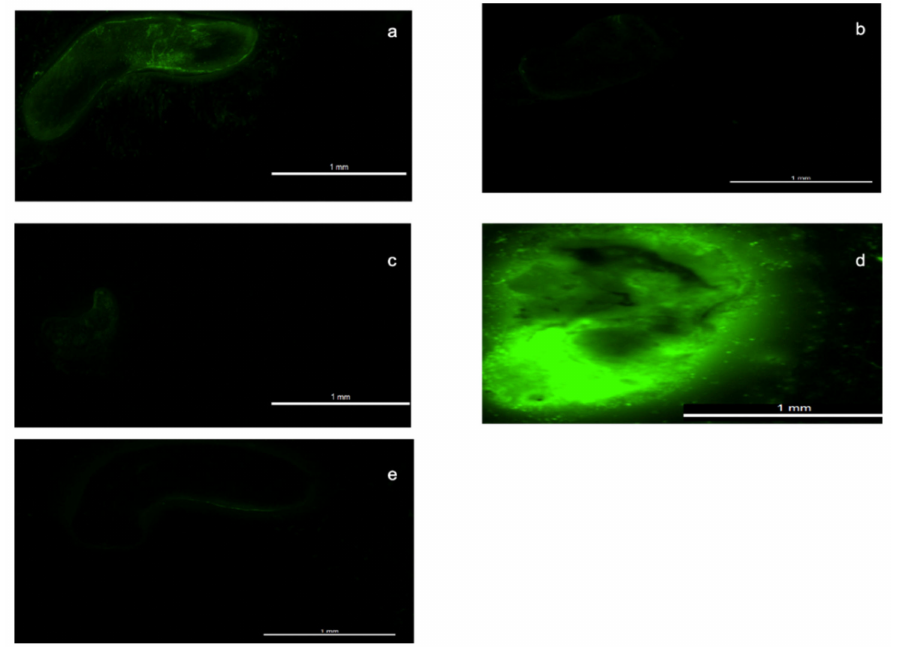
Figure 7. Exemplar fluorescent images of artificial pond water (APW) with fluorescein in DMSO ( e ), and after planaria were exposed to PAA ( a ), PMD ( b ), copolymer ( c ), and benzalkonium chloride (BKC) ( d